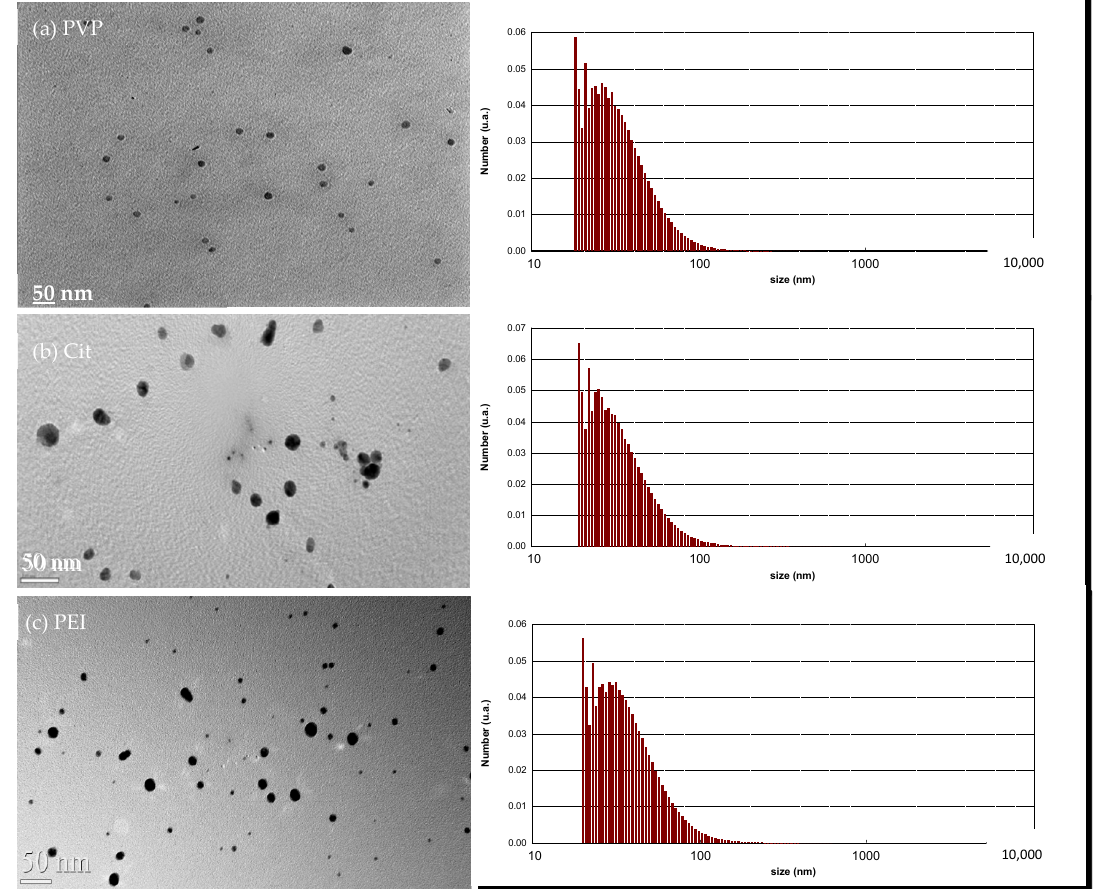
Figure 1. Size distribution and Transmission electron microscope (TEM) image of different AgNPs: ( a ) AgNP-PVP; ( b ) AgNP-Cit; and ( c ) AgNP-PEI.